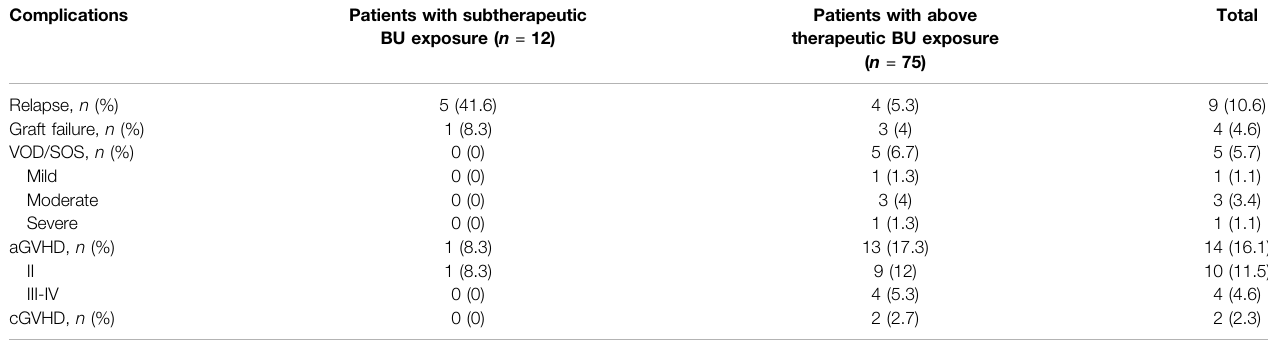
TABLE 2 | Complications after HSCT. Complications Patients with subtherapeutic